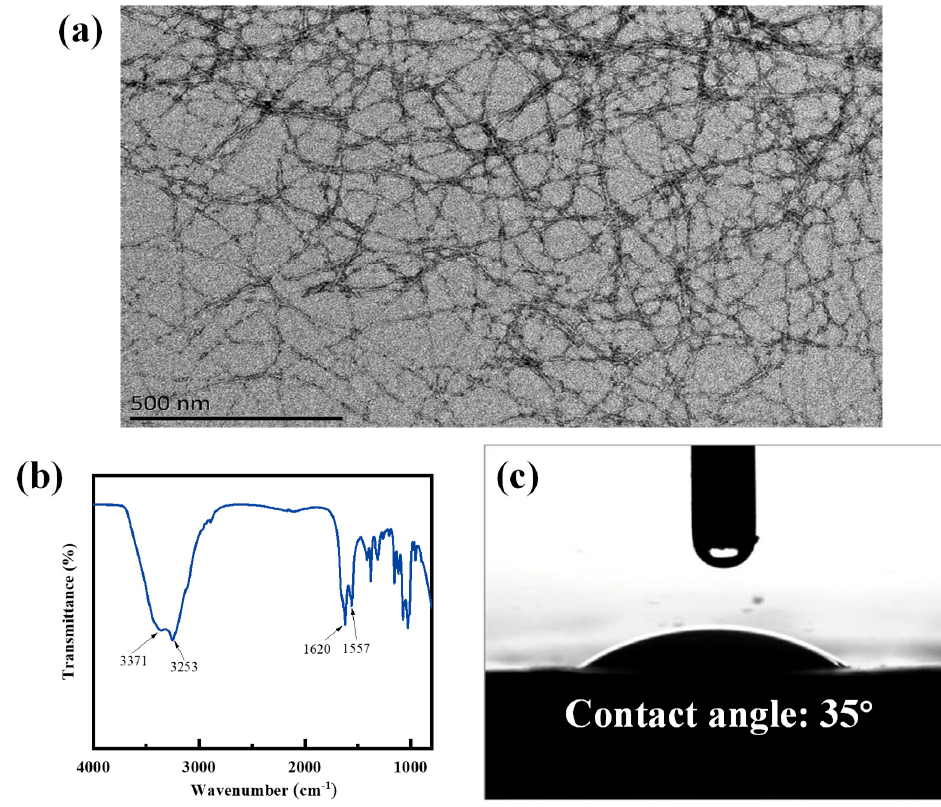
Figure 3. ( a ) TEM, ( b ) FTIR, and ( c ) water contact angle of the prepared